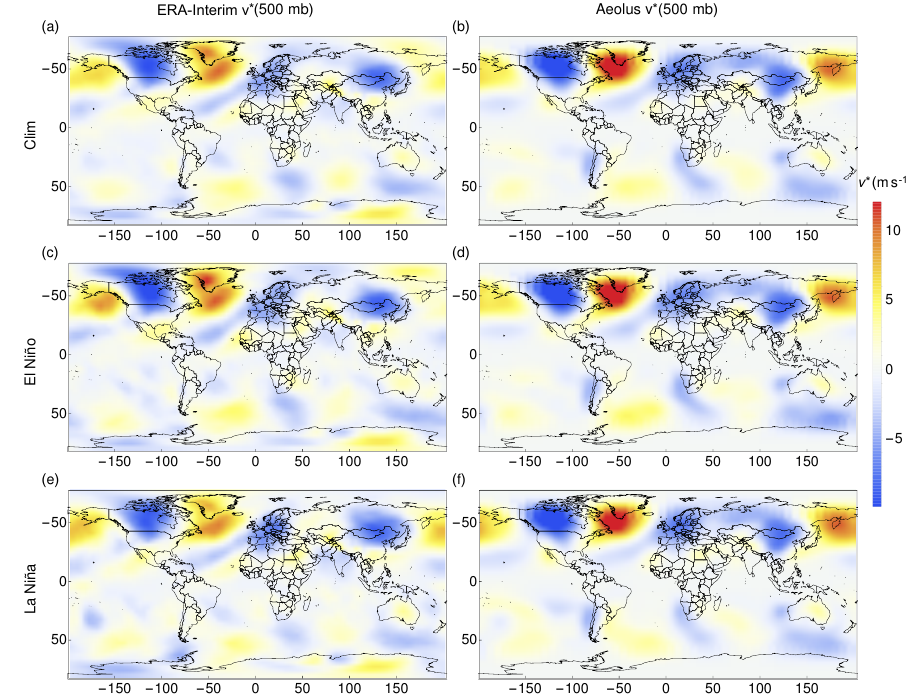
Figure 3. Azonal large-scale meridional wind velocity v ∗ at 500mb for February (compare Fig. 1).